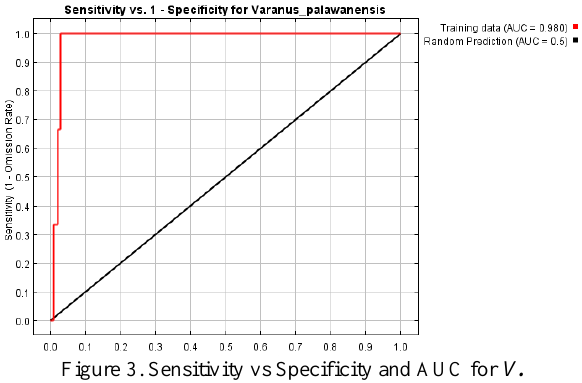
Figure 3. Sensitivity vs Specificity and AUC for V.